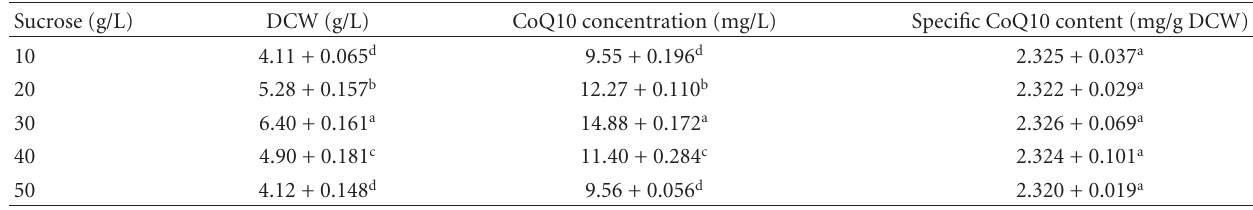
Table 3: E ff ect of sucrose on DCW and CoQ10 production by PK38 with batch culture.